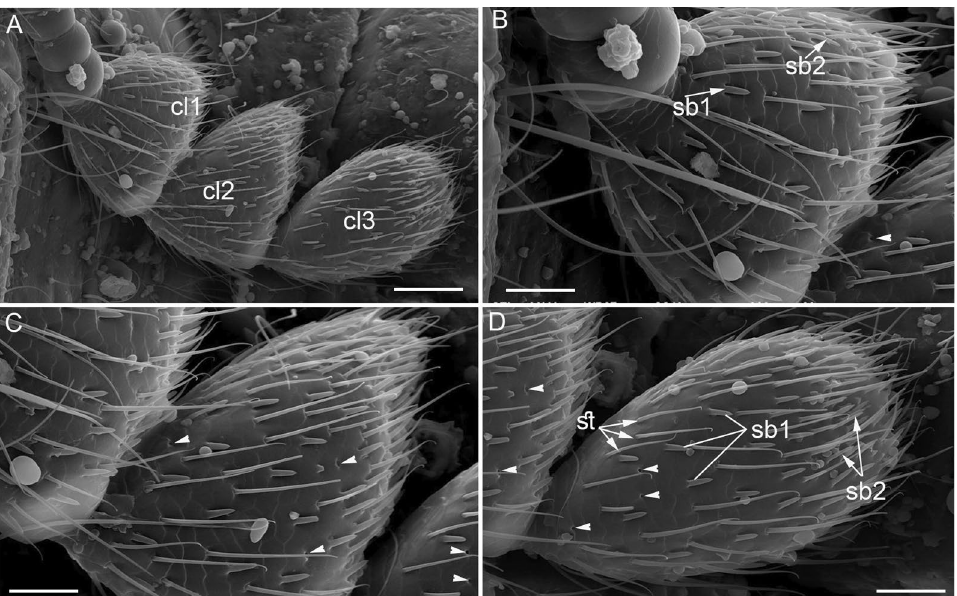
Fig. 3 Scanning electron micrographs of the distal part of the antenna of adult Rhyzopertha dominica . A The three flagellomeres of the club (cl1– cl3) and their sensilla. Scale bar 50 μm. B–D The spatial distribution of sensilla of club flagellomeres; cl1 ( B ), cl2 ( C ), cl3 ( D ) which densely packed = with numerous sharp tipped s. trichodea (st), short blunt tipped s. basiconica (sb1 and sb2) and s. ampullacea (amp) (arrow heads)